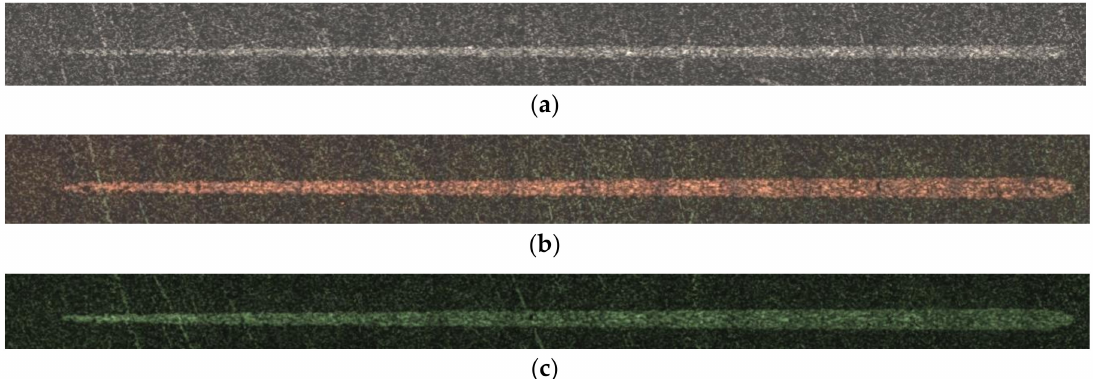
Figure 10. The tracks of the indenter displacement at loads from 1 to 40 N onto the surface of the samples of Al 2 O 3 + SiC ceramic with various coatings: ( a ) diamond-like coating (DLC); ( b ) TiZrN coating; ( c ) TiCrAlN